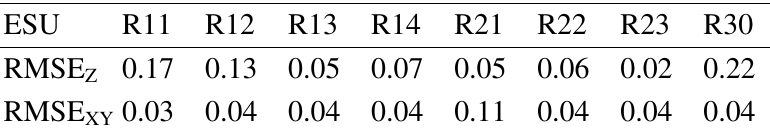
Table 6. Root mean square error in cm of generated DSM height values compared to the manually measured GCPs.